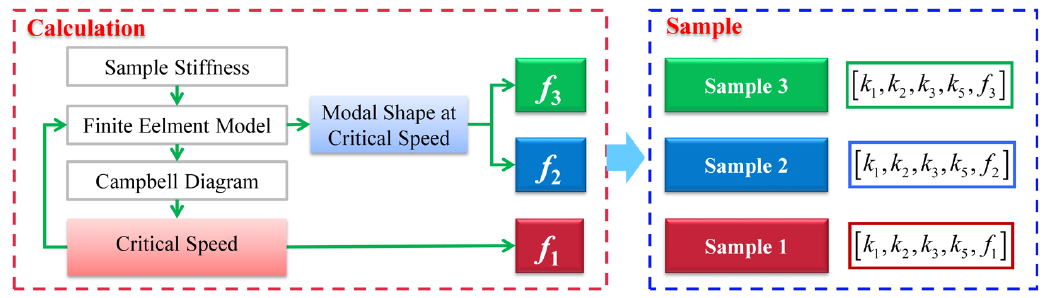
Figure 17. Sample calculation processes.